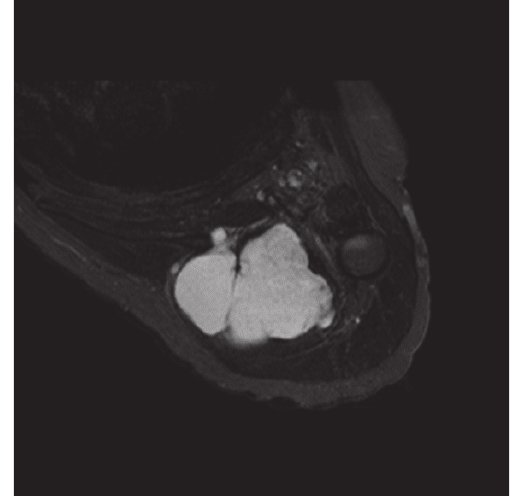
Figure 1: STIR and T2-weighted transverse MRI. Observe the huge cystic-like hyperintense mass growing inside the deltoid muscle and invading the scapula. The mass contains some septations but there is no apparent solid component.